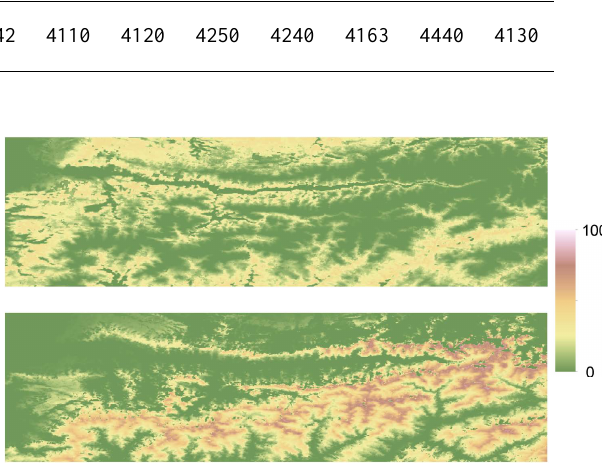
Figure 7. SPI (top) and LPI (bottom) values of each pixel (in %) in the study area defined in Fig.